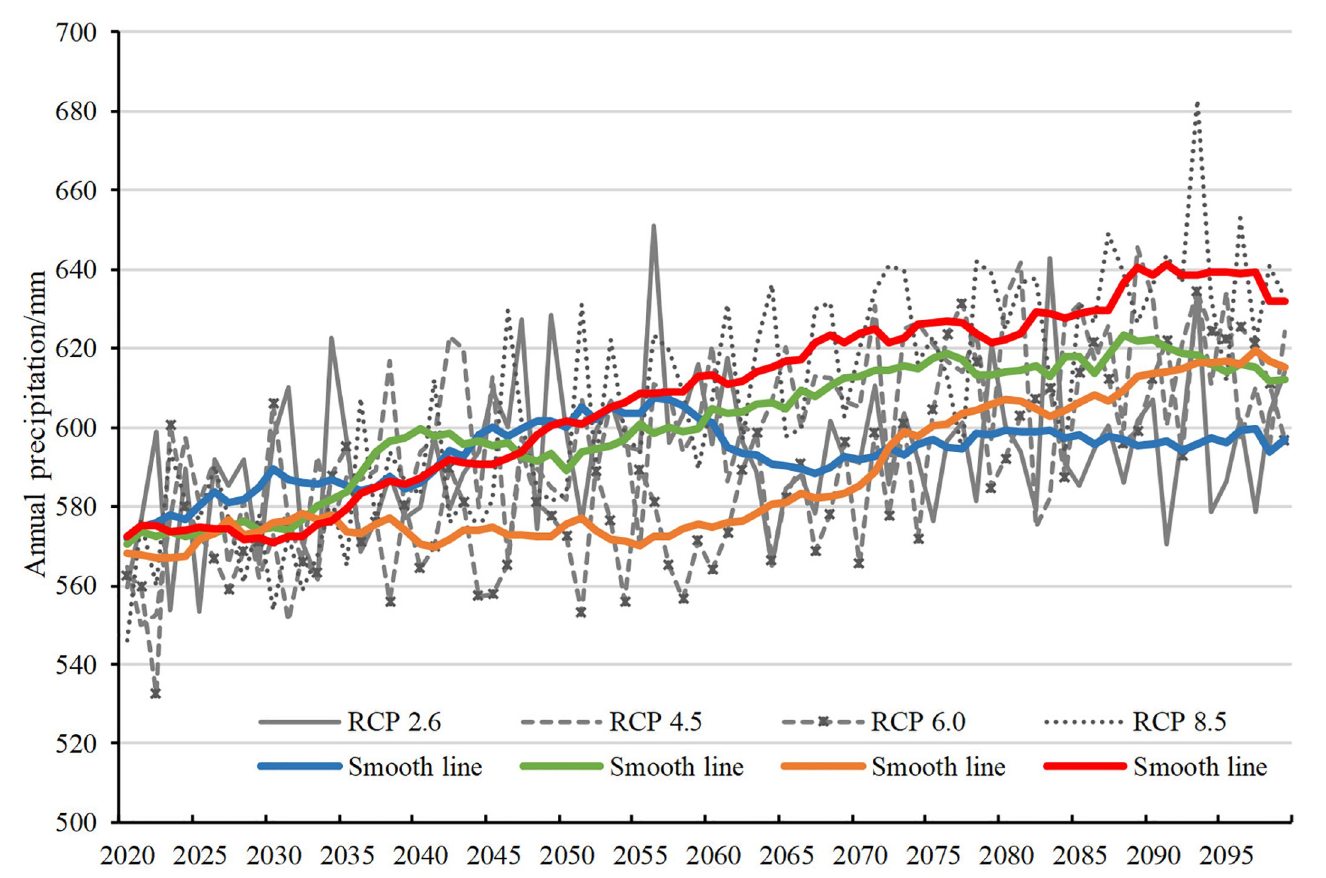
Fig 4. Average annual precipitation in China under the four